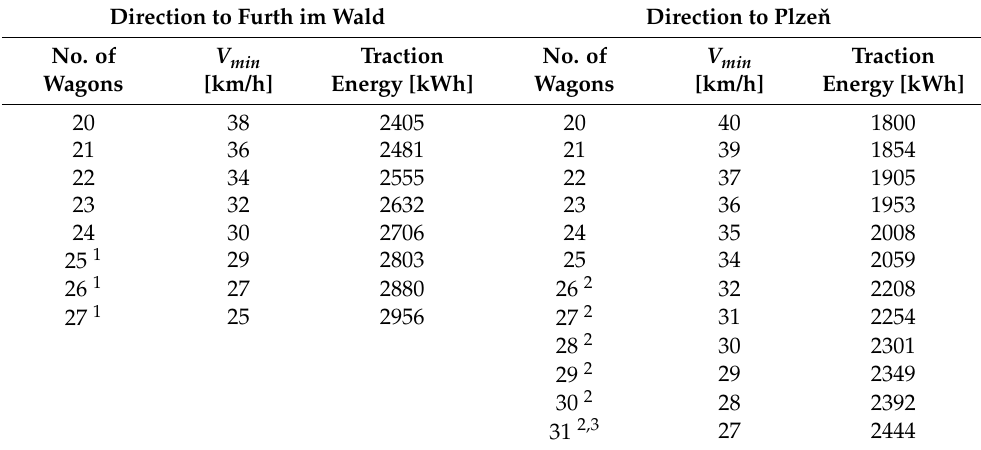
Table 9. Sensitivity analysis for the model train with Siemens locomotive on the line 180.